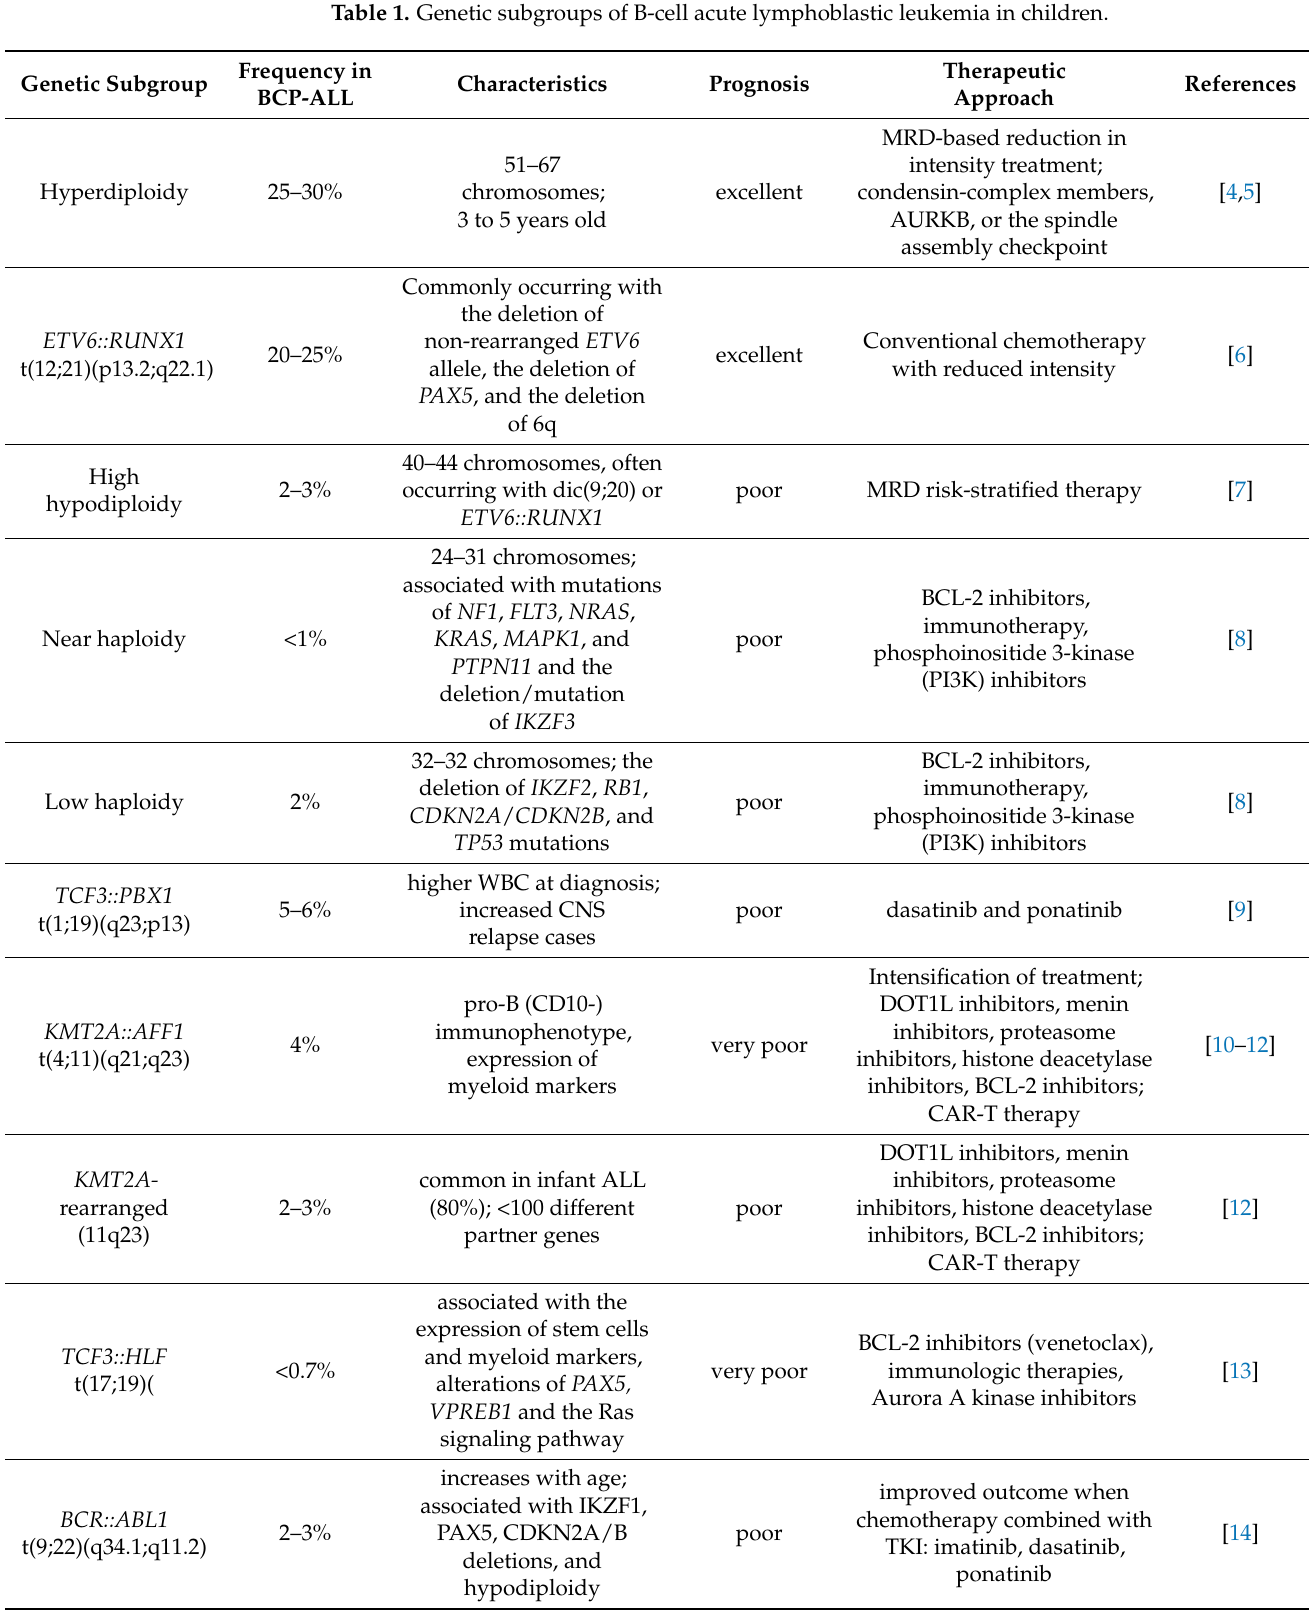
Table 1. Genetic subgroups of B-cell acute lymphoblastic leukemia in